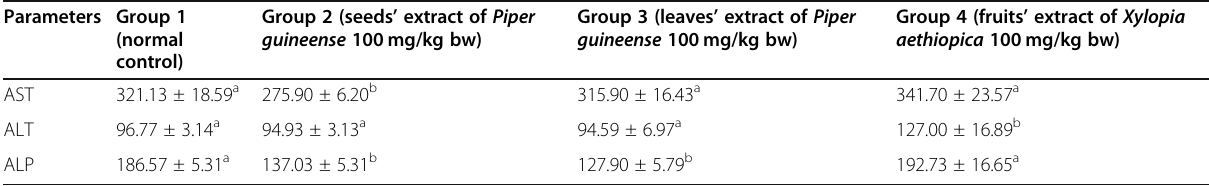
Table 1 Liver enzymes activity (IU/L) in rats administered ethanolic extracts of fruits of Xylopia aethiopica and seeds and leaves of Piper